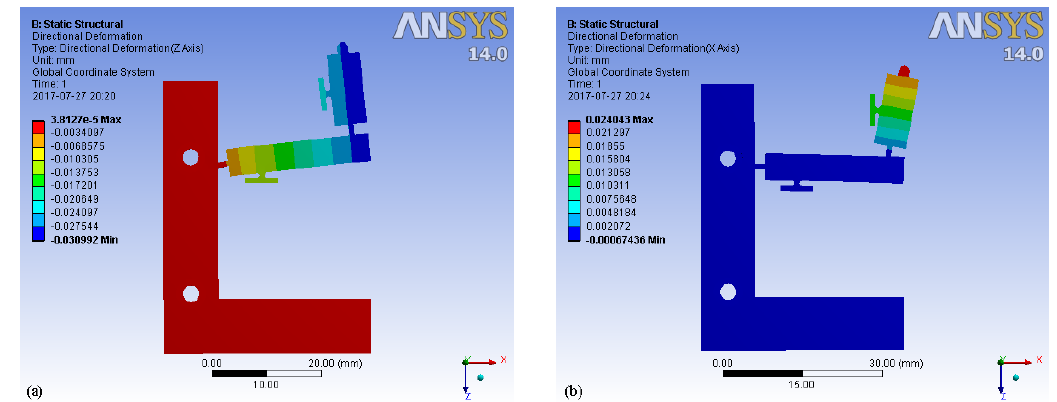
Figure 12. The magnification ratio k 1 and k 2 of the compliant lever mechanism based on the CRF. (a) Displacement diagram of k 1 ; (b) displacement diagram of k 2 .